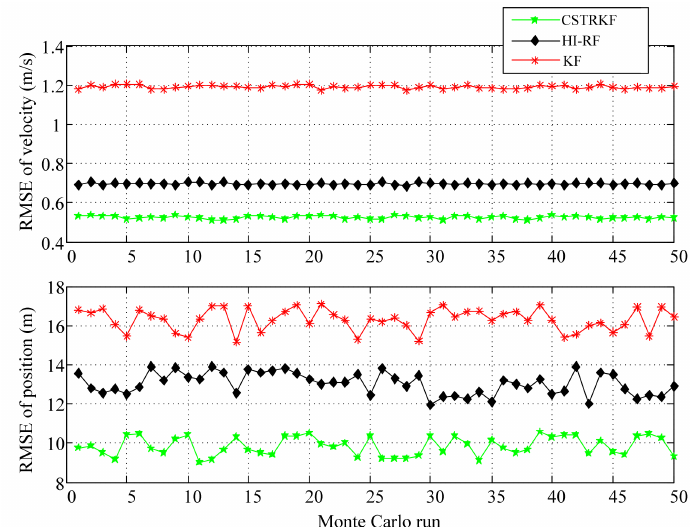
Figure 10. RMSEs of velocity and position measurements in the INS / SRS / CNS integrated system with di ff erent filters under a contaminated Gaussian measurement noise